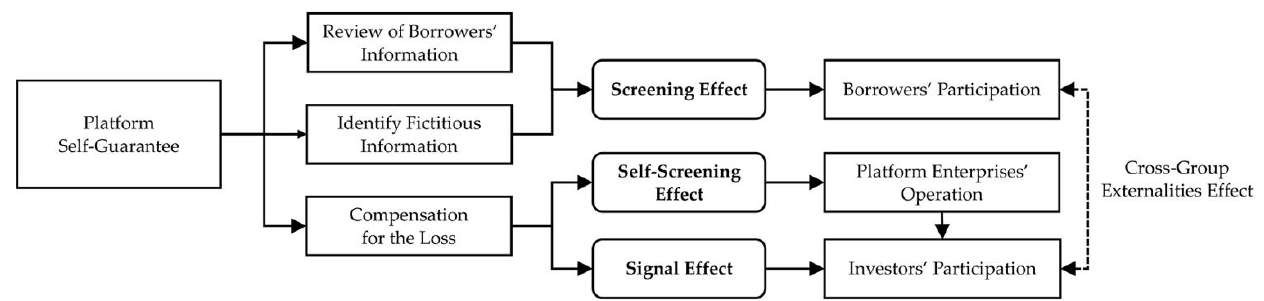
Figure 5. The influence pathway of the platform self-guarantee mechanism on platform users’ participation. Analysis of Third-Party Guarantee